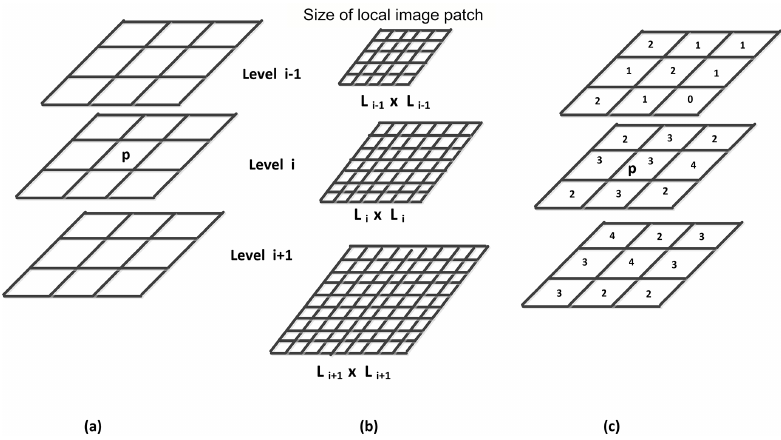
Figure 3. Voting in the scale space of a 3 × 3 × 3 neighborhood: (a) structure of the scale space neighborhood; (b) size of the local image patch at different levels; (c) number of votes in the scale space neighborhood.